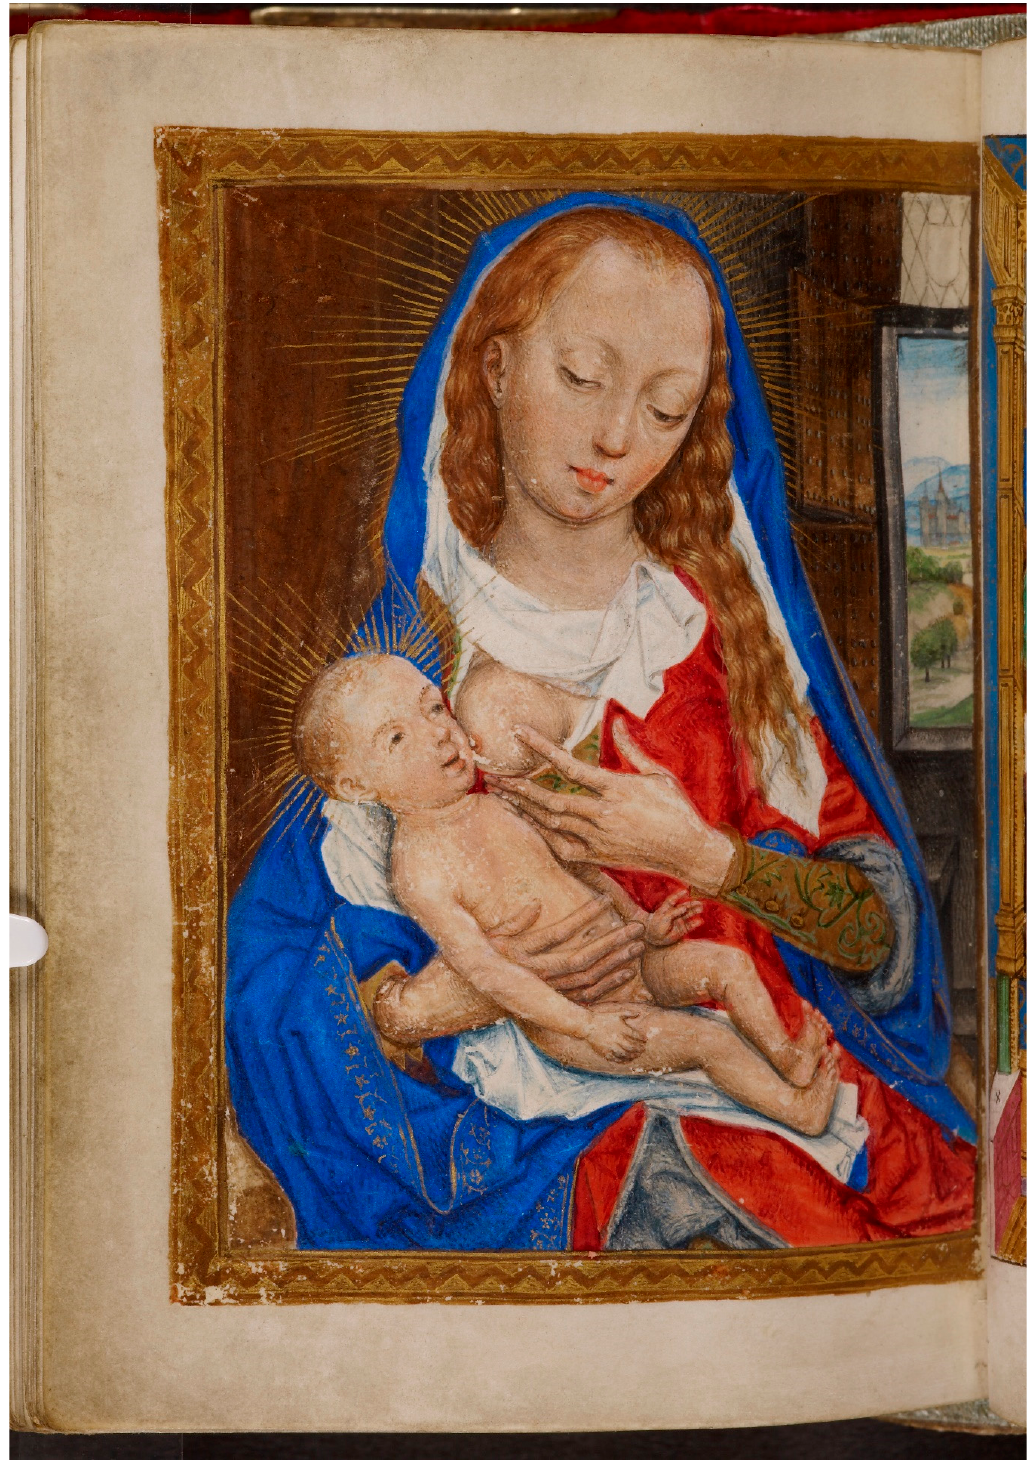
Figure 2. London, British Library, Add. MS 18852, fol. 287v. Virgin and Child, Virgo lactans.